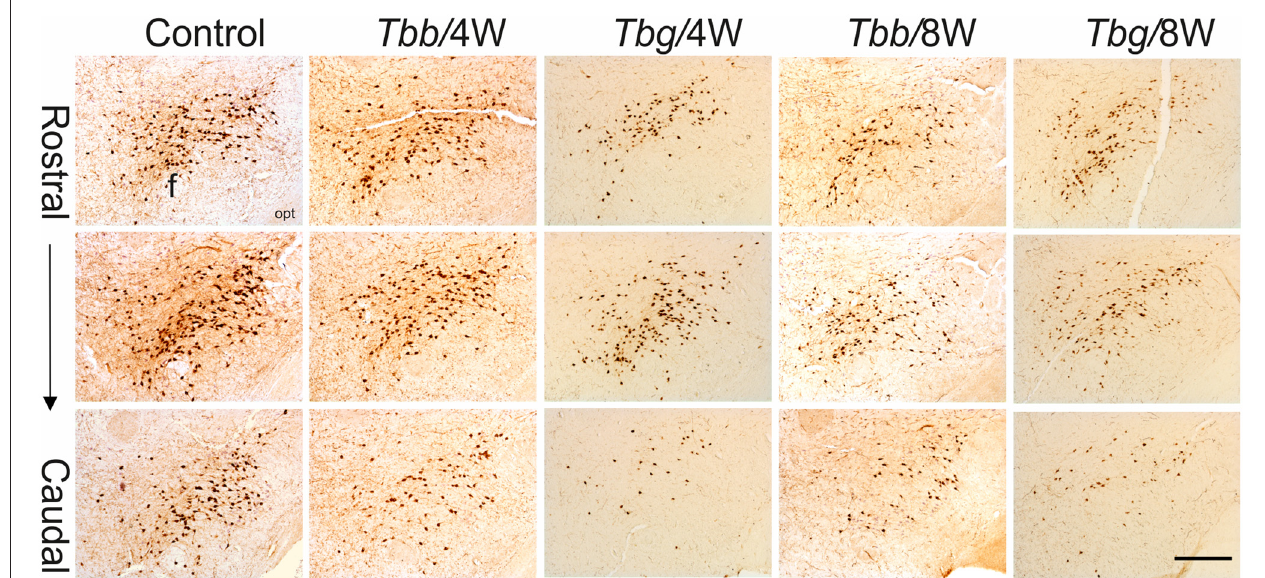
FIGURE 2 | Low power view of orexin (OX)-A-immunoreactive neurons in the perifornical area and lateral hypothalamus of Mastomys natalensis at 4 weeks (W) and 8 W after infection with Trypanosoma brucei brucei ( Tbb ) or Trypanosoma brucei gambiense ( Tbg ) and in uninfected animals. Note the rarefaction of immunostained cell bodies and the reduction of neuropil immunolabeling in the infected animals. Abbreviations: f, fornix; opt, optic tract. Scale bar: 250 µ m.